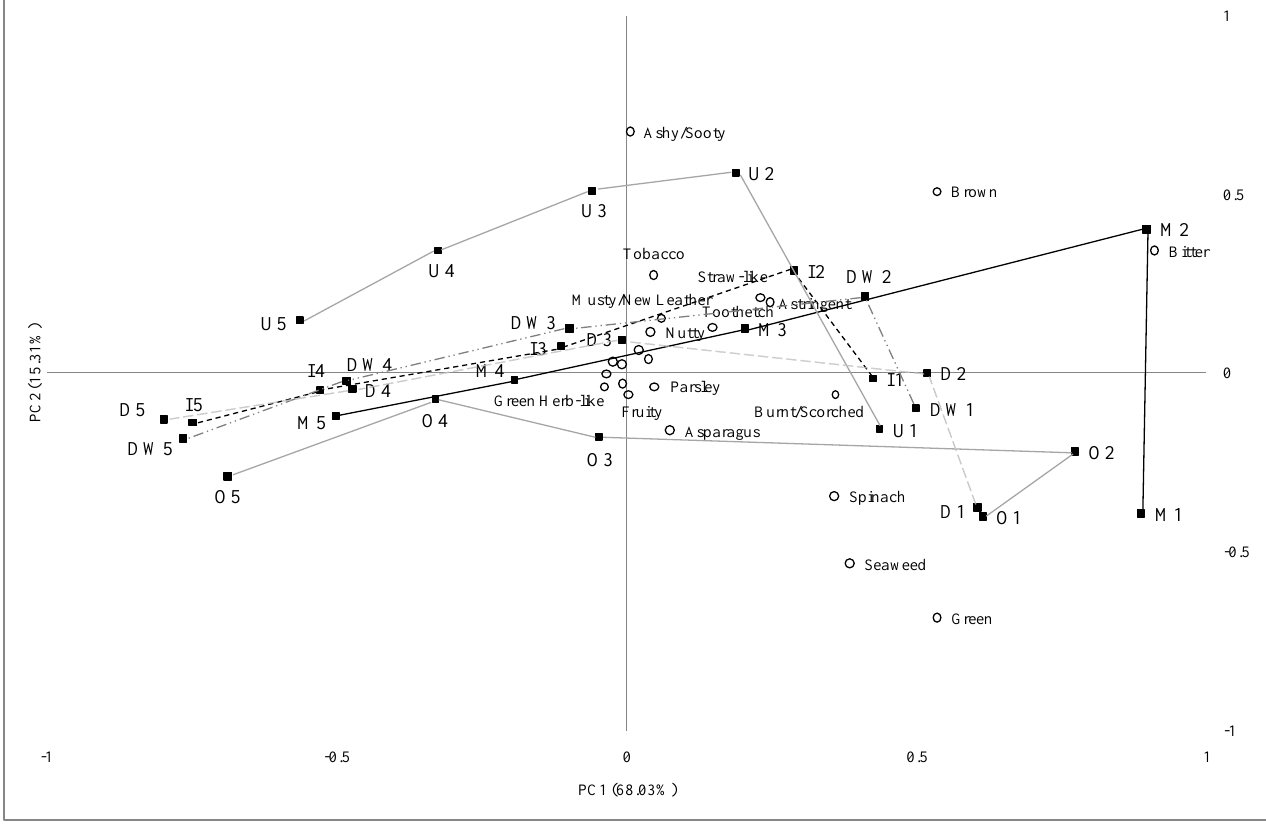
Figure 1. Principal component analysis biplot of descriptive sensory analysis of green teas a, b